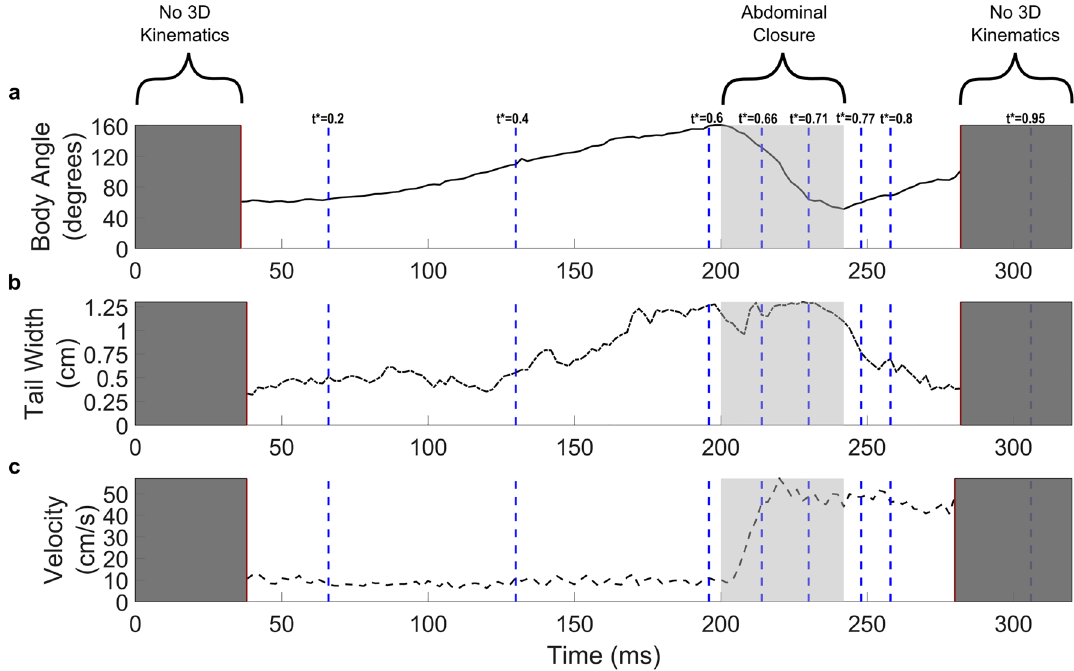
Figure 2. Time records of ( a ) body angle, ( b ) tail width, and ( c ) velocity of E. superba as it performs the caridoid escape maneuver. Body angle was measured by calculating the angle between 2 vectors created using three points along the body: the eye, the middle of the dorsal side of the abdomen, and the base of the tail (i.e., points 1, 4, and 7, respectively, in Supplementary Fig. S1). The tail width was measured by calculating the length between the left and right tips of the tail. The velocity was calculated by ensemble averaging the motion of all 14 points defined in Supplementary Fig. S1. The dark grey shaded regions represent portions of the recordings where 3D kinematics were not able to be calculated. The light grey shaded region corresponds to the abdominal closure portion of the caridoid escape maneuver. The dashed blue lines indicate the time points of the images displayed in Fig. 1 and Supplementary Fig.